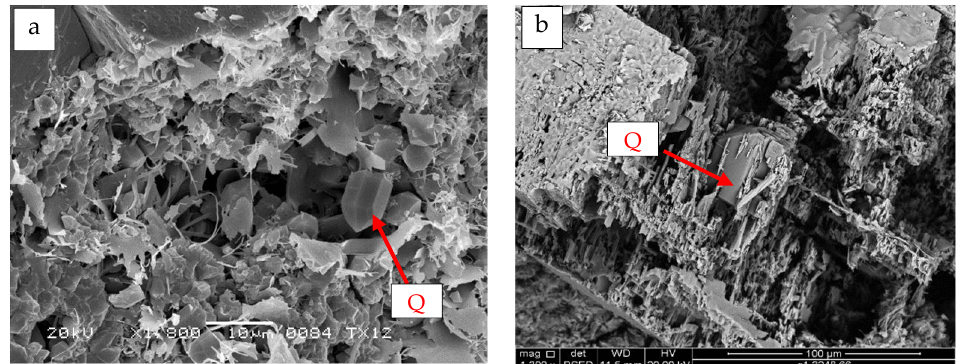
Figure 10. Scanning electron microscopy images showing the characteristics of the quartz cements. ( a ) Dissolution pores of rock fragments filled with authigenic quartz and illite, X10 well, 4880.54 m; ( b ) Dissolution pores of feldspar filled with authigenic quartz, ZT1 well, 3673.05 m.